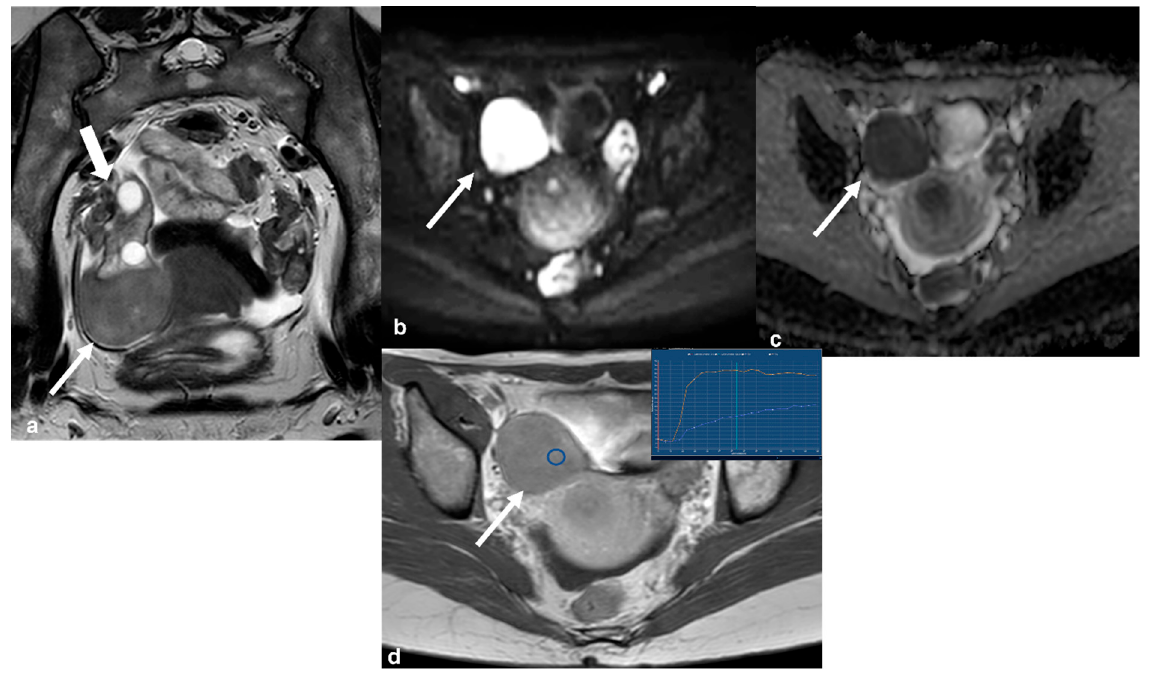
Figure 10. Cellular fibrothecoma. T2 weighted image in the axial oblique plane ( a ) demonstrates a rather low signal intensity lesion (long white arrow) attached to the lower pole of the right ovary (short white arrow). Corresponding axial high b value (1200) diffusion weighted image ( b ) and ADC map ( c ) show restricted diffusion of the lesion (arrow in ( b , c )). The lesion shows avid contrast uptake on axial CE T1 weighted image (( d ), arrow). DCE analysis of the lesion shows a type 1 time–intensity curve (inset in ( d ), blue line: lesion; orange line: uterus; blue circle: region of interest (ROI) within the lesion).